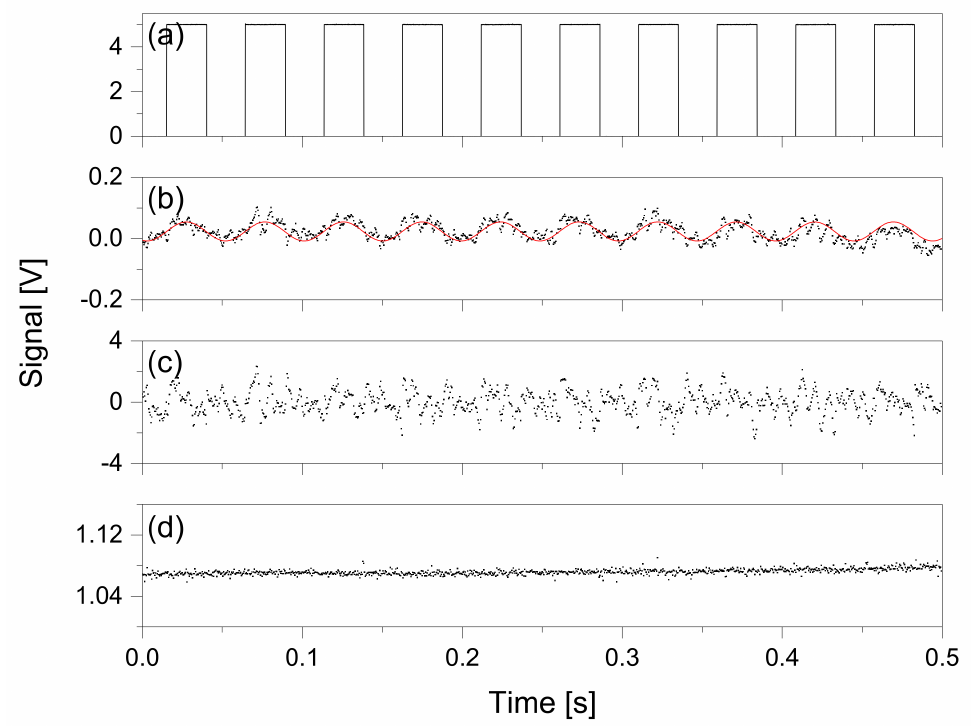
Figure 3. Signal processing in the measurement using the MP cell. ( a ) External reference TTL signal to generate the chopper at a repetition frequency of 20 Hz. ( b – d ) Time traces measured at PCB test points (TP) with an oscilloscope, measured at TP1, TP2, and TP3, respectively. ( b ) Modulated raw signal detected by the detector, with the non-linear fitted curve with sinusoidal function (red). The signal amplitude was 0.06 V (peak to peak), and the noise was calculated by the root mean square (rms) of the fit residual, while the signal to noise ratio (S/N) was 3.14. ( c ) Demodulated signal, where the waveform was identified by fitting with squared sinusoidal function. ( d ) Final DC signal which passes through the LPF. The signal size was 1.071 V, indicating a 17-fold increase when compared to the raw signal. The S/N was 277, indicating an 88-fold improvement when compared to the raw signal. The DC signal presented an accuracy of 0.72% ( k = 2) for 0.5